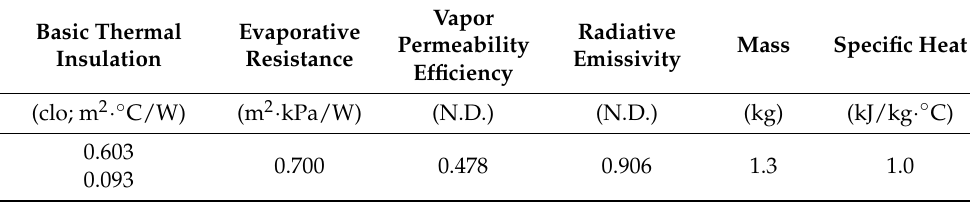
Table 3. Global clothing properties for working profiles G_12 and G_14. (Favorable (phases 01, 05, and 09), moderate (phases 03 and 07), and stressful periods (phases 02, 04, 06, and